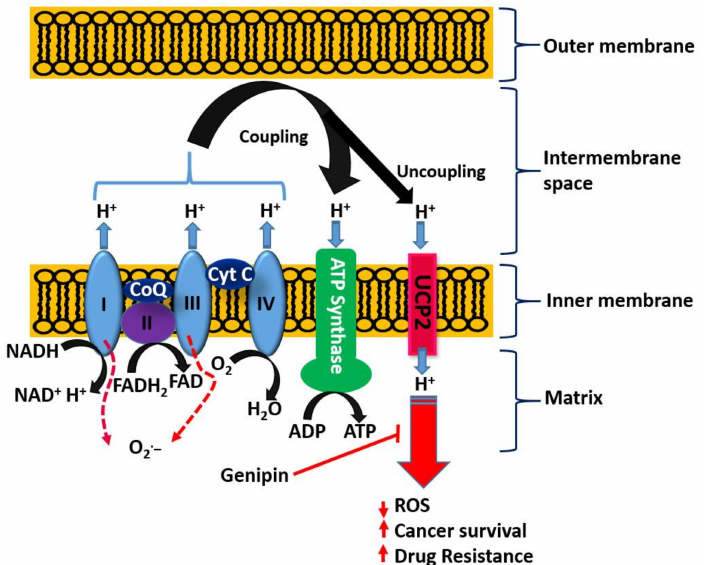
Figure 4. Targeting UCP2 by genipin in cancer. The electron transport chain in the